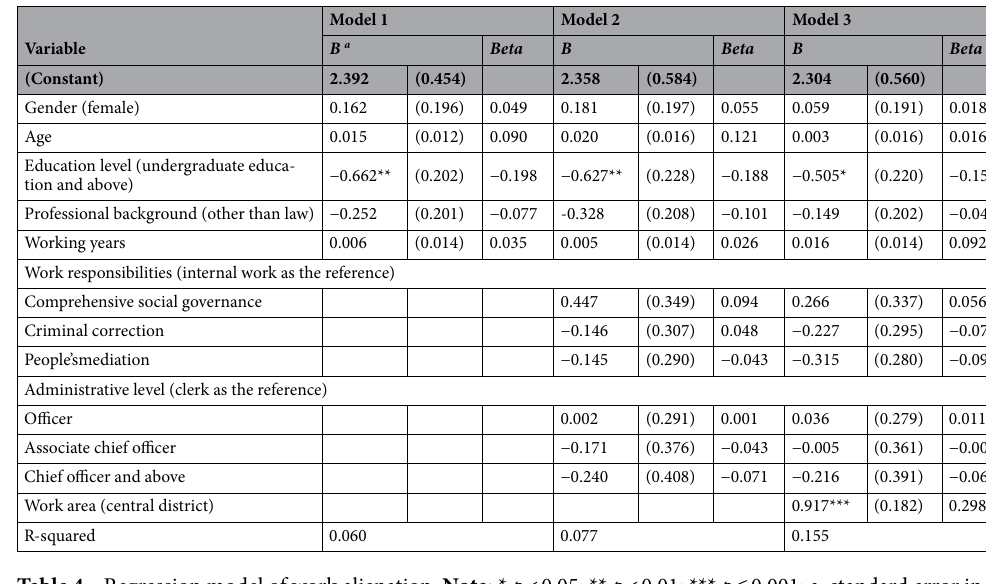
Table 4. Regression model of work alienation. Note: * p < 0.05; ** p < 0.01; *** p ≤ 0.001; a. standard error in parentheses.